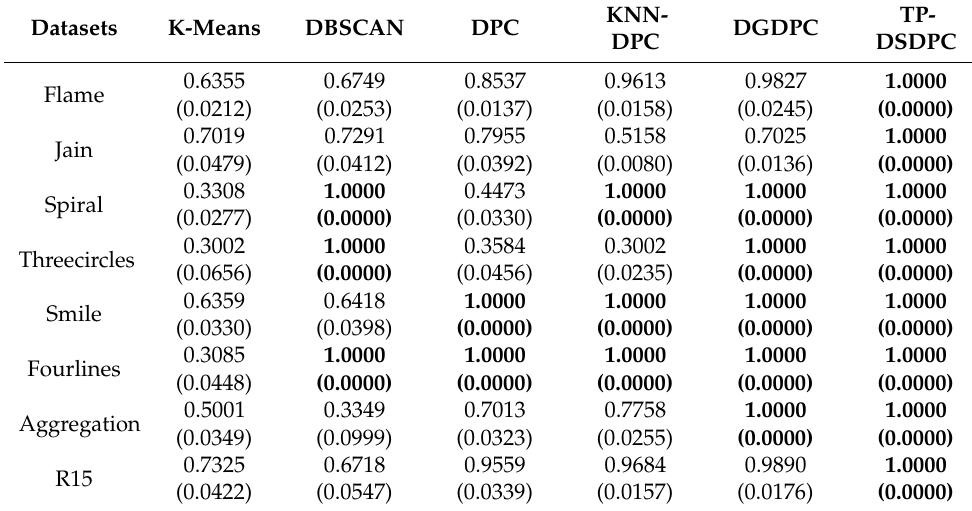
Table 4. The ACC of the six algorithms on nine synthetic datasets.